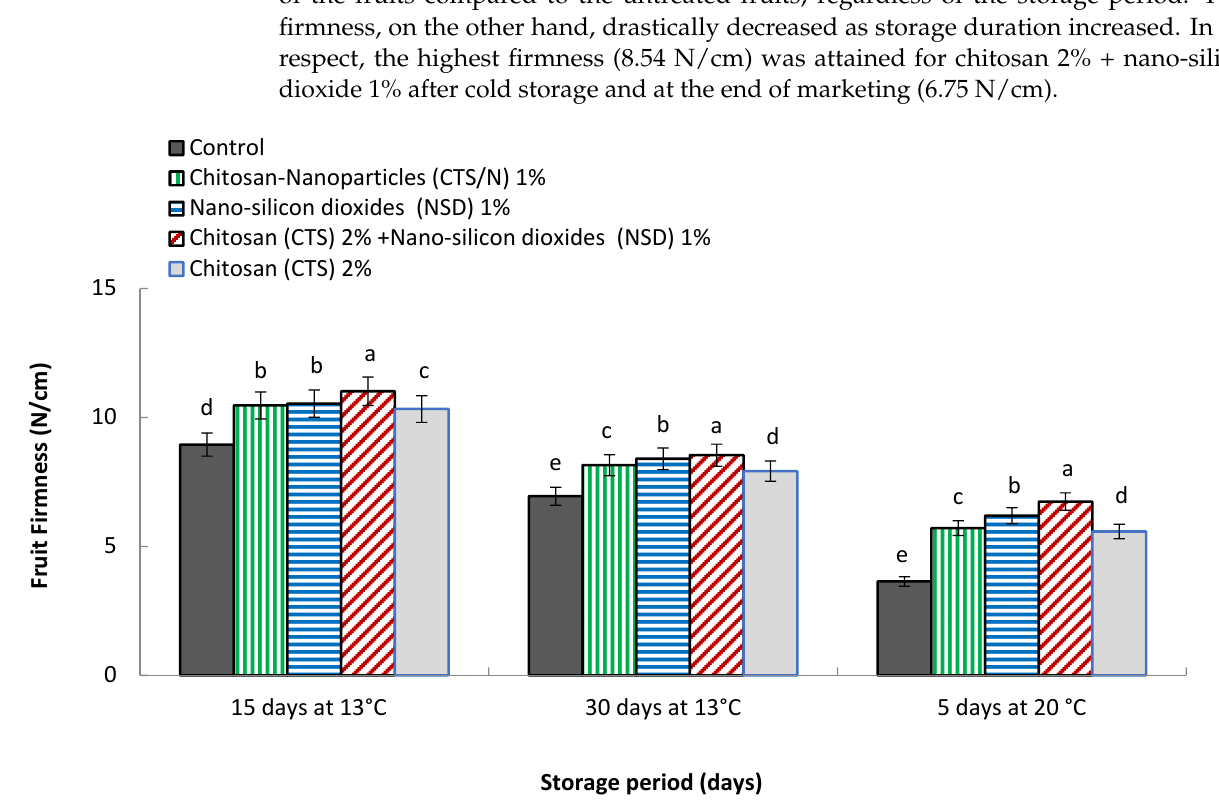
Figure 5. Ethylene production (µL C2H4 kg − 1 h − 1 ) as a mean of ‘Tommy Atkins’ mangoes from two seasons, stored at 13 ± 1 °C and 90–95% RH for 30 days. Afterward, the fruits were stored at 20 ± 2 °C and 70–75% RH for 5 days as the marketing period. Vertical bars indicate the standard error